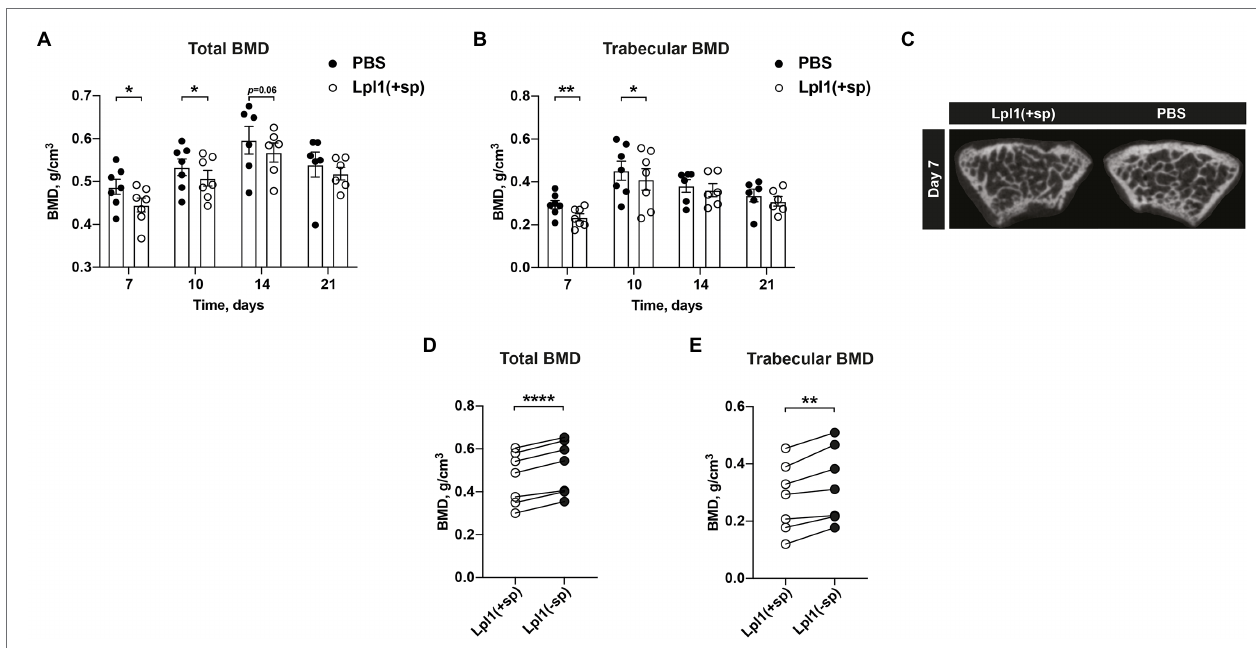
FIGURE 2 | Intra-articular injection of Staphylococcus aureus Lpp induces BMD loss in a lipid-moiety dependent manner. (A) The total- and (B) trabecular BMD (g/cm 3 ) measured on day 7, 10, 14, and 21 post intra-articular (i.a.) knee joint injection of 20 μ l of purified S. aureus lipoprotein Lpl1(+sp; 10 μ g/knee) or 20 μ l of PBS, in NMRI mice ( n = 6–7/group). (C) Representative micro-CT images of the mice knee joints i.a injected with S. aureus Lpl1(+sp; left panel) or PBS (right panel) on day 7. Measurements of the (D) total- and (E) trabecular BMD on day 7 of mice knee joints ( n = 7/group) i.a. injected with 20 μ l of intact purified S. aureus lipoproteins